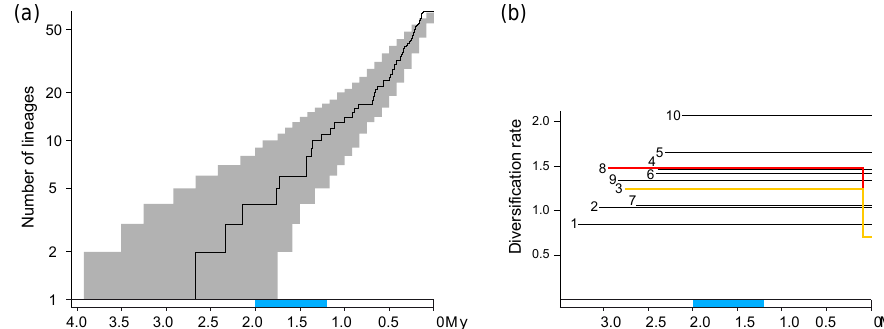
Figure 4. (a) LTT plot for the endemic non-pyrgulinid Hydrobiidae in Lake Ohrid. The plot is based on a relaxed-clock BEAST analysis, with the black line showing the BEAST MCC and the shaded area indicating the 95% confidence interval based on 20000 post-burn-in BEAST trees. The blue bar ranging from 1.2 to 2.0My shows the assumed age of Lake Ohrid. (b) Diversification rates obtained from the diversification-rate analyses (TreePar); trees with a single shift in diversification rates at 0.1My (trees nos. 3 and 8) are highlighted in red and yellow. Table 2. Reduced output of the diversification-rate analyses (TreePar). P values > 0.95 indicate that a single shift in rates explains the tree significantly better than constant diversification rates, that two shifts explain the tree significantly better than a single shift, or that three shifts explain the tree significantly better than two shifts (see main text for